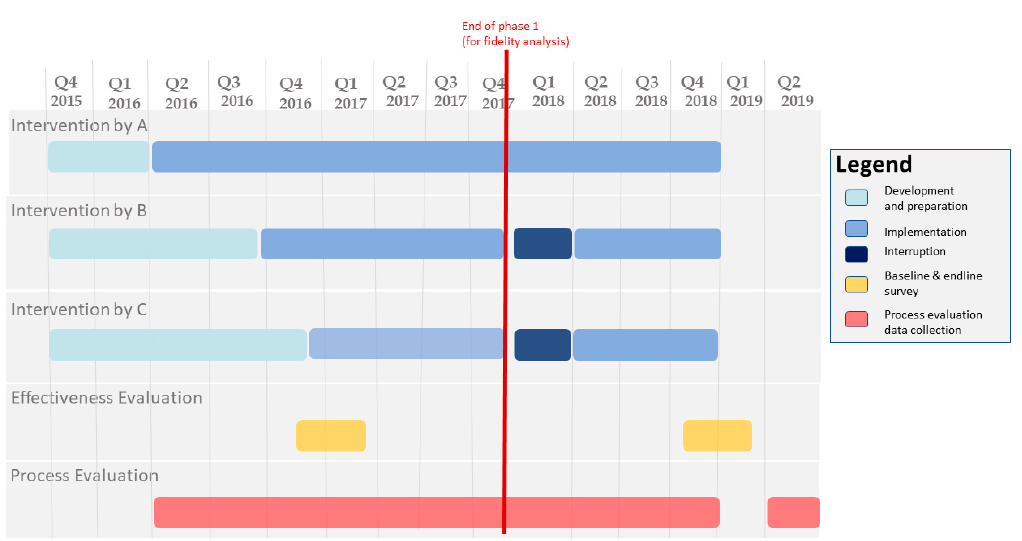
Figure 2. Timeline for OHEP intervention. Implementer A (A, B, and C are codes used to anonymise the three non-governmental-organization implementers) started implementation in March 2016, while Implementers B and C started in September 2016 and December 2016, respectively. The baseline and end line surveys were conducted in the last quarters of 2016 and 2018, respectively. The quantitative data for process evaluation were collected throughout the implementation period, while the qualitative data were collected in the 2nd quarter of